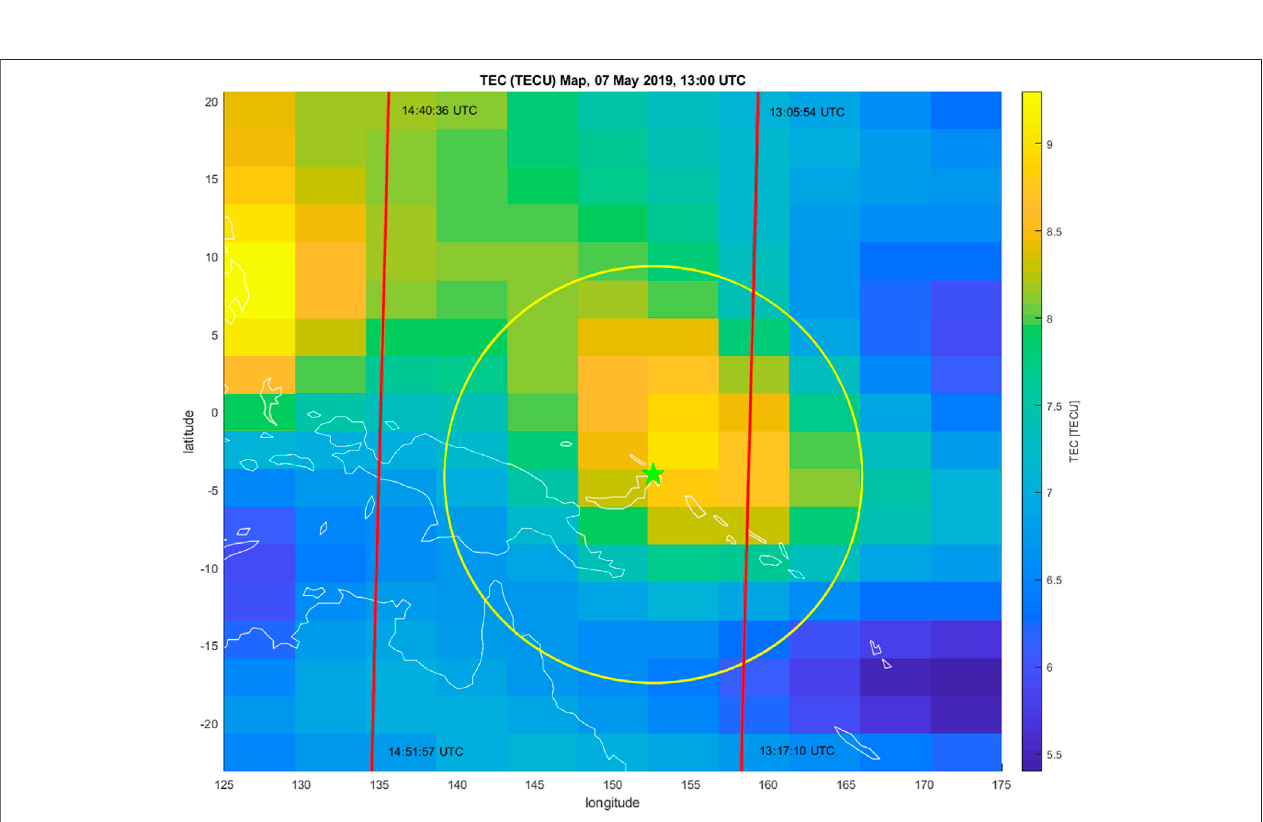
, (C) detected TEC anomalies when | Interquartile